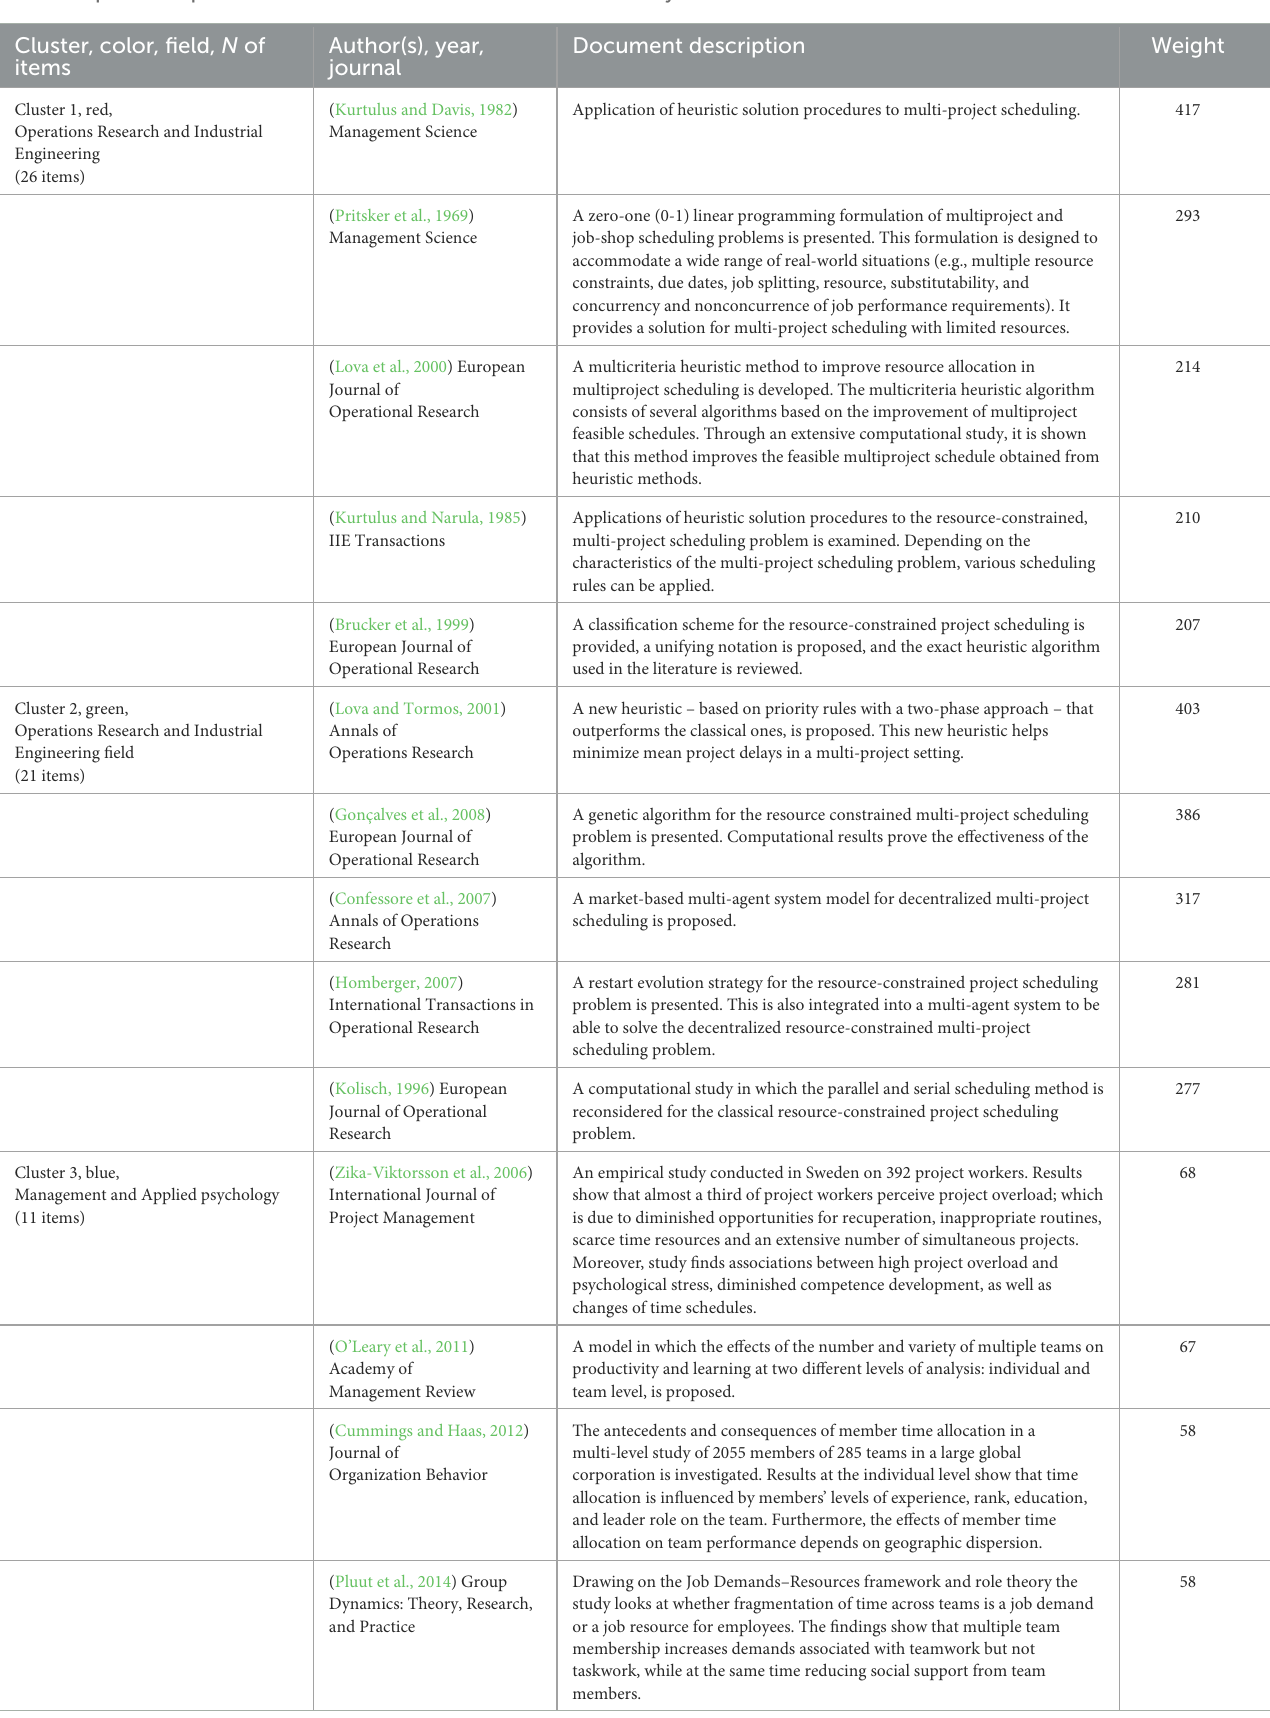
TABLE 1 Top 5 most important documents for each cluster in the co-citation analysis. Cluster, color, field, N of